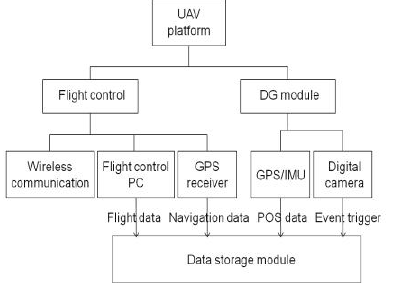
Table 1 Comparison of various airborne photogrammetric Figure 2 Configuration of proposed DG-ready UAV